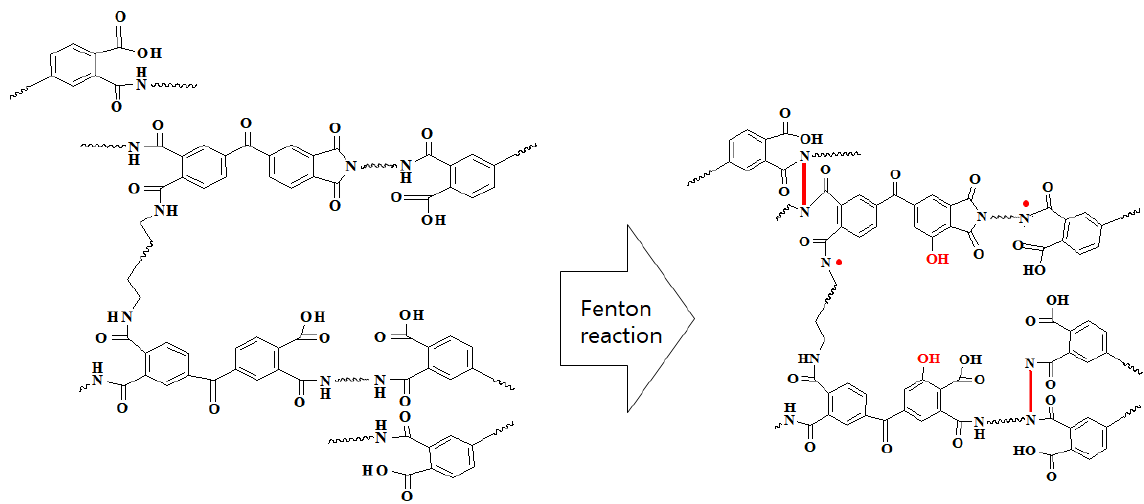
Figure 8. Cross-linking of Duramem900 PI membrane using the Fenton reaction. Figure 8. Cross ‐ linking of Duramem900 PI membrane using the Fenton reaction.